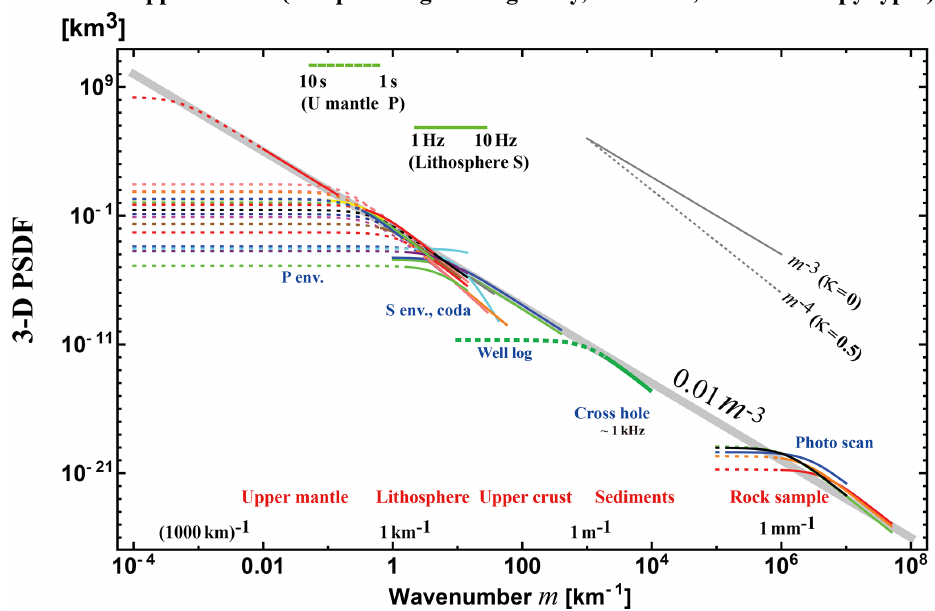
Figure 9. 3-D PSDF vs. wavenumber for the crust and the upper mantle. Data of Gaussian-type, anisotropy type, strong heterogeneity, the lower mantle, and the whole mantle are excluded. The light-gray straight line visually fits to most spectral